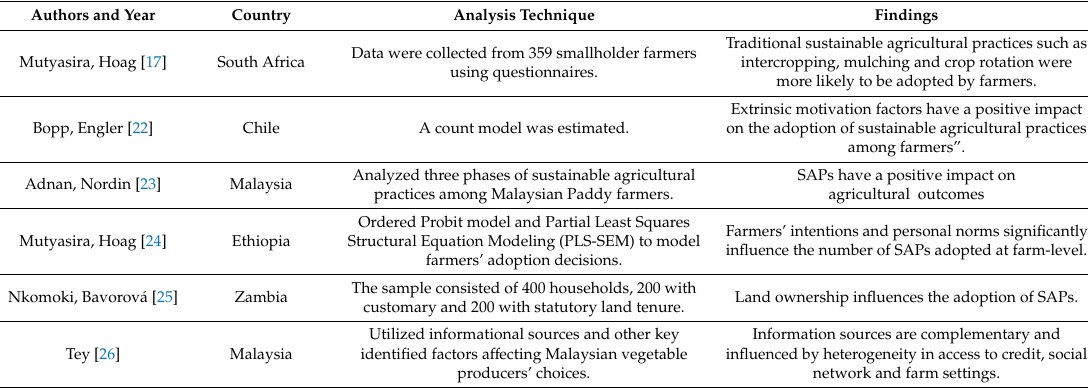
Table 1. Latest studies on farmer’s adoption of sustainable agricultural